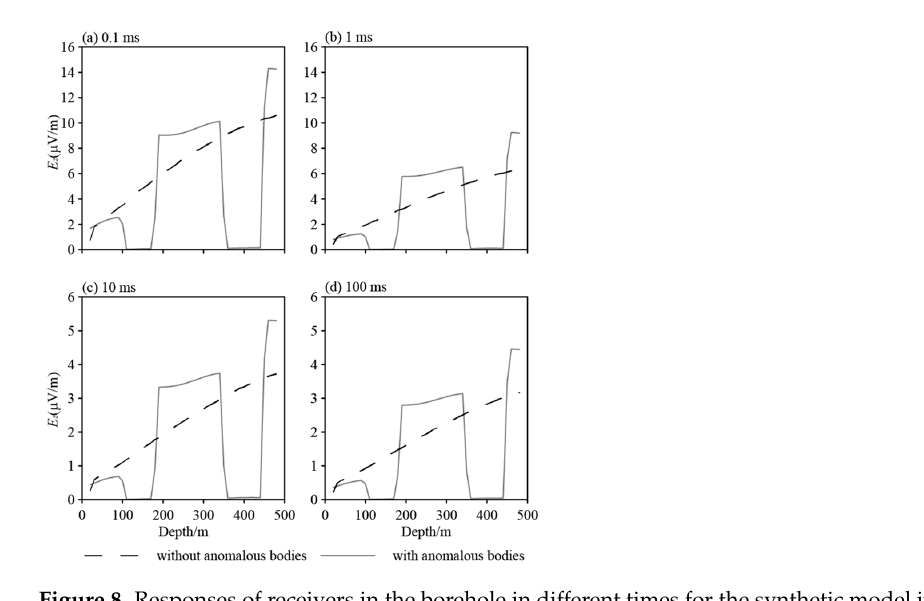
Figure 7. Three 3D abnormal bodies embedded in a topographic half-space.